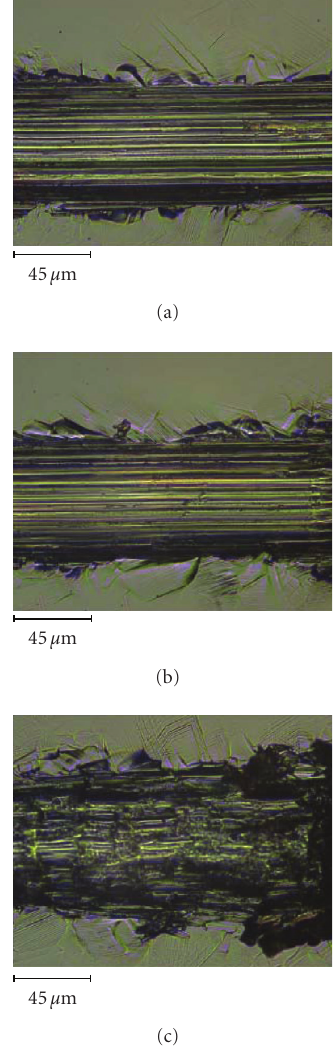
Figure 3: Residual scratch profiles of SS AISI 304 at scratch speed (a) 1mm/min, (b) 3mm/min, and (c) 27mm/min at progressive load ranging between 1N to 15N for constant sliding distance of